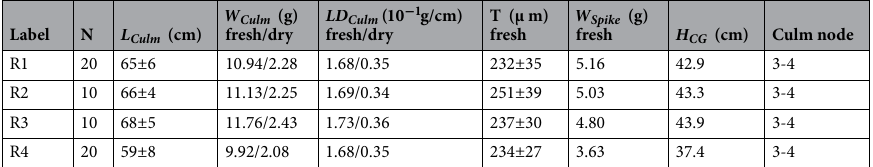
Table 2. The number of samples (N), average length (L Culm ), weight (W Culm ), length density (LD Culm ) for a single culm. The wall thickness (T) of the fresh basal culm. The fresh spike weight (W Spike ), height of center of gravity (H CG ), culm node of rice plants. The symbol ± in table refers to the distribution range of data.